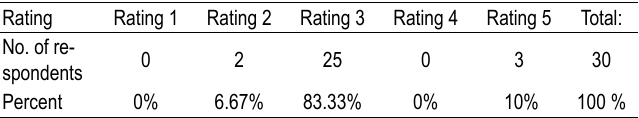
Table 6. Status of patients before therapy